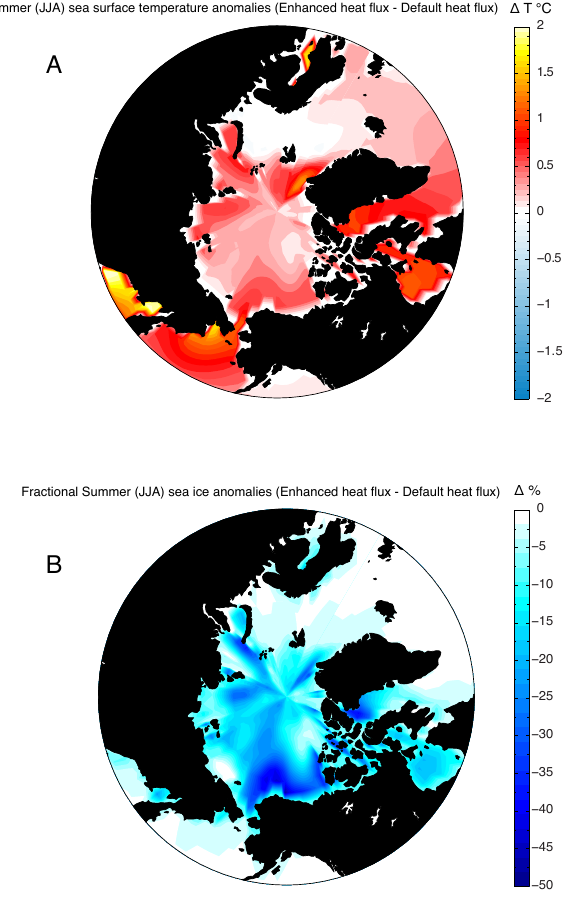
Figure 5. Model simulated (MIS11NG) summer sea surface tem- perature and sea ice anomalies caused by enhanced oceanic heat flux ( + 8Wm − 2 ) at 409ka: (a) summer (JJA) sea surface tempera- ture change with respect to default heat flux simulation ( T ◦ C) and (b) summer (JJA) sea ice fraction anomalies (%) with respect to de- fault heat flux simulation. With + 8Wm − 2 of subsea ice heat flux convergence, Arctic Ocean SSTs rise >0.5 ◦ C and sea ice fraction decreases 25–50% in most